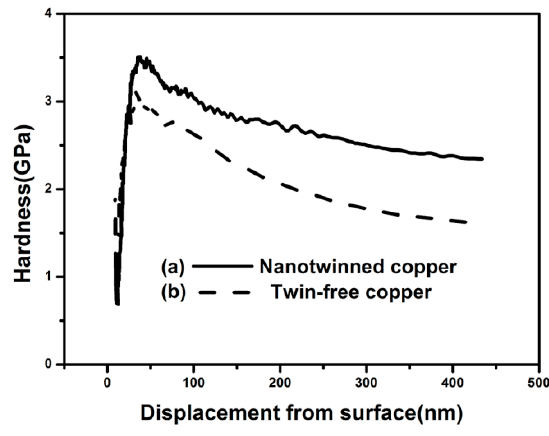
Figure 3. The measured hardness vs displacement from the surface for ( a ) a nanotwinned copper pillar and ( b ) a twin-free copper pillar on the cross-section of the TSV. and ( b ) a twin-free copper pillar on the cross-section of the